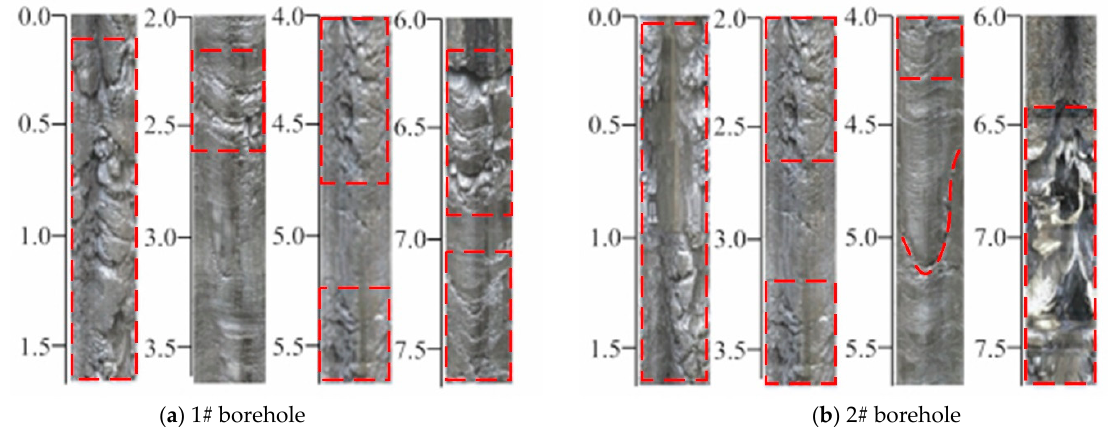
Figure 7. Fractures of surrounding rocks from borehole television imager.